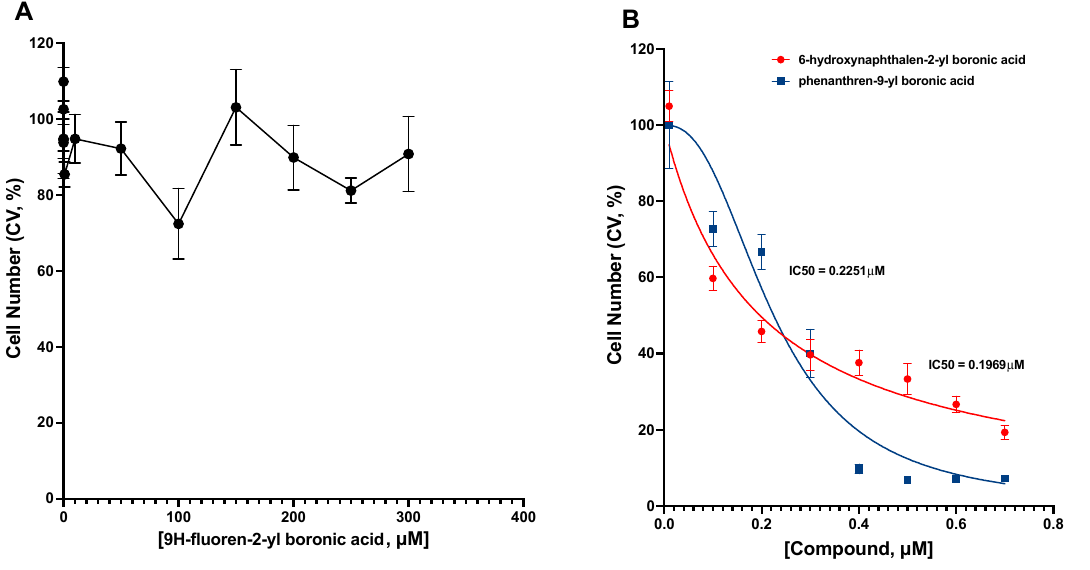
Figure 8. The e ff ects of BCC on 4T1 cell viability. ( A ). E ff ect of compound 1 on cell viability. ( B ). Figure 8. The effects of BCC on 4T1 cell viability. ( A ). Effect of compound 1 on cell viability. ( B ). E ff ects of compound 4 and compound 5 on cell viability . Assays were performed in triplicate. Data Effects of compound 4 and compound 5 on cell viability. Assays were performed in triplicate. Data are presented as the mean ± SE of the cell viability of 4T1 cells in culture. are presented as the mean ± SE of the cell viability of 4T1 cells in